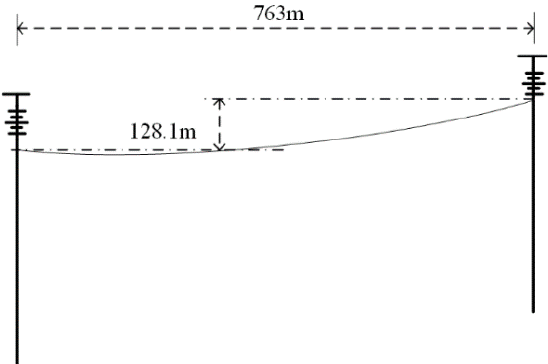
Figure 5. Sectional diagram of the transmission line. Table 2. Physical parameters of the conductor.